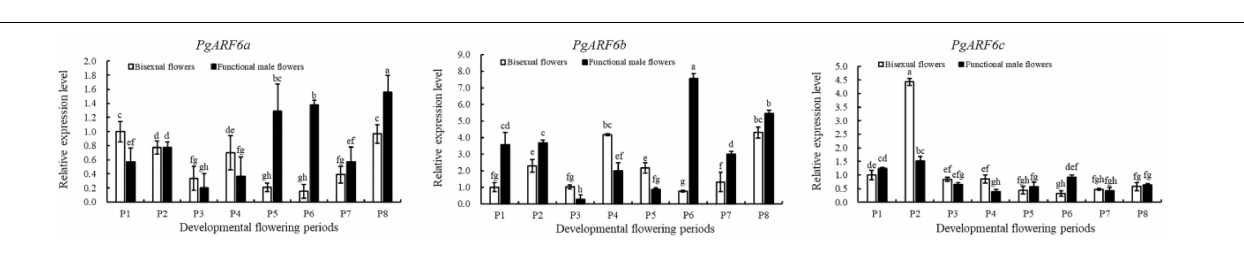
FIGURE 8 | Expression analyses of PgARF6s under 6-BA